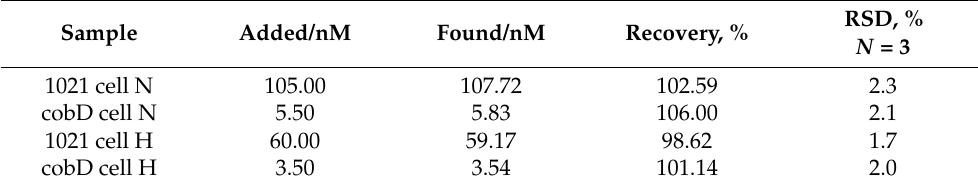
Figure 6. Comparison of the electrochemical signal without metal ion removal and with metal ion removal. Table 2. Results for the determination of VB12 in real samples.